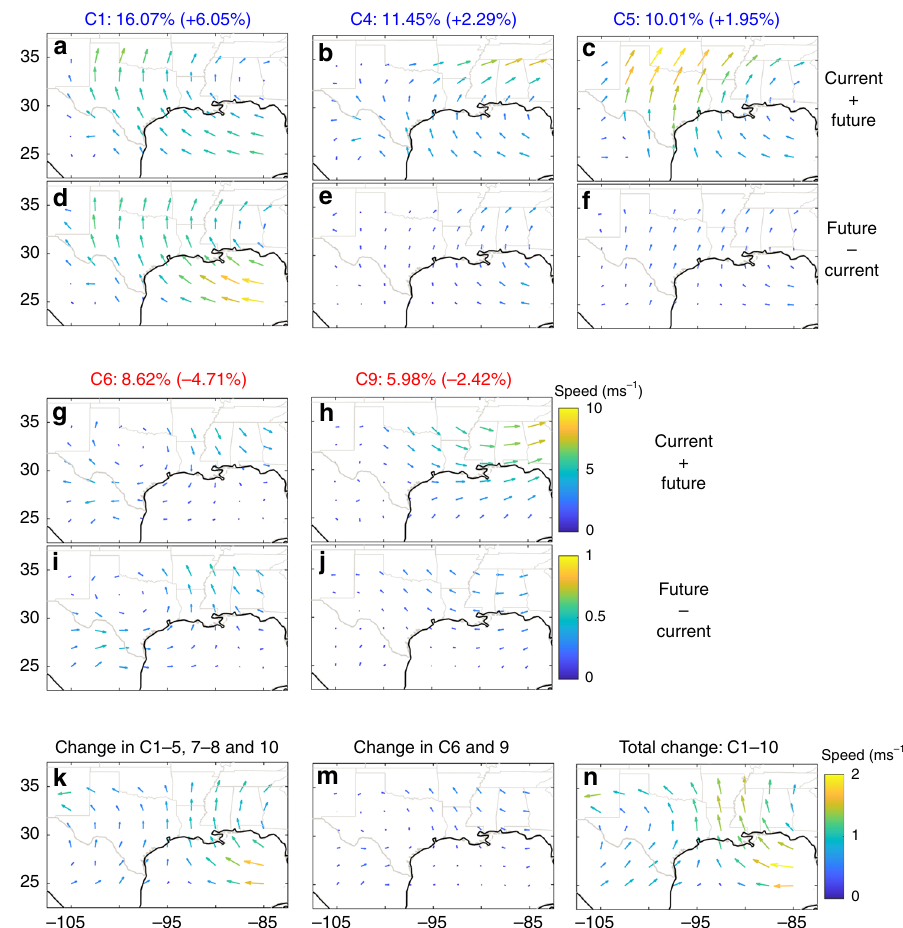
Fig. 3 Changes in daily steering wind regimes between current and future climates in the Large Ensemble Community Project (LENS) dataset. Vectors of daily June to September steering wind are classi fi ed into 10 clusters using the self-organizing map (SOM) analysis applied to the current (1979 – 2005) and future (2074 – 2100 under RCP8.5) periods combined together. All cluster centers and their frequencies are shown in Supplementary Fig. 13. For each cluster i , the frequency f C i ð f F i Þ is de fi ned as the number of days in the current (future) period in that cluster divided by the total number of days in the current ( = future) period. Panels a – c and g , h show the cluster centers and their frequency, (cid:1) f i ¼ ð f C i þ f F i Þ = 2, for the fi ve clusters with the largest changes between the future and current climates. Numbers in parentheses are the change in the frequency of patterns within each cluster ( f F i (cid:2) f C i ; see Supplementary Fig. 14). Clusters C1, C4, and C5 (C6 and C9) have strong northward (southward) steering winds over Texas. Panels d – f and i , j show the change within each cluster due to change in frequency and change in pattern (future minus current; see Supplementary Fig. 16). k ( m ) shows the change, future minus current, in clusters with weak or northward (southward) steering winds over Texas. Panel ( n ) shows the change across all clusters, i.e., the sum of the changes in panels k and m , which is approximately the change in June to September-averaged steering wind vectors. Panels a – c and g – h , panels d – f and i, j , and panels k – n have the same colorbars. The arrow size and colormap of panels d – f and i , j (panels k – n ) are scaled such that their values are 1/ 10 (1/5) of those in panels a – c and g – h